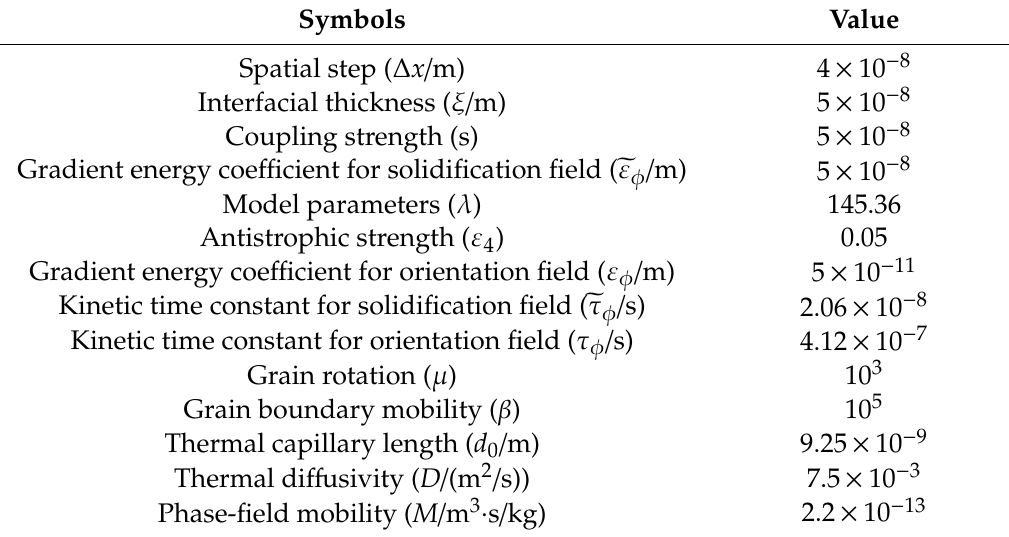
Table 3. Model parameters of supersonic droplet impacting on a substrate